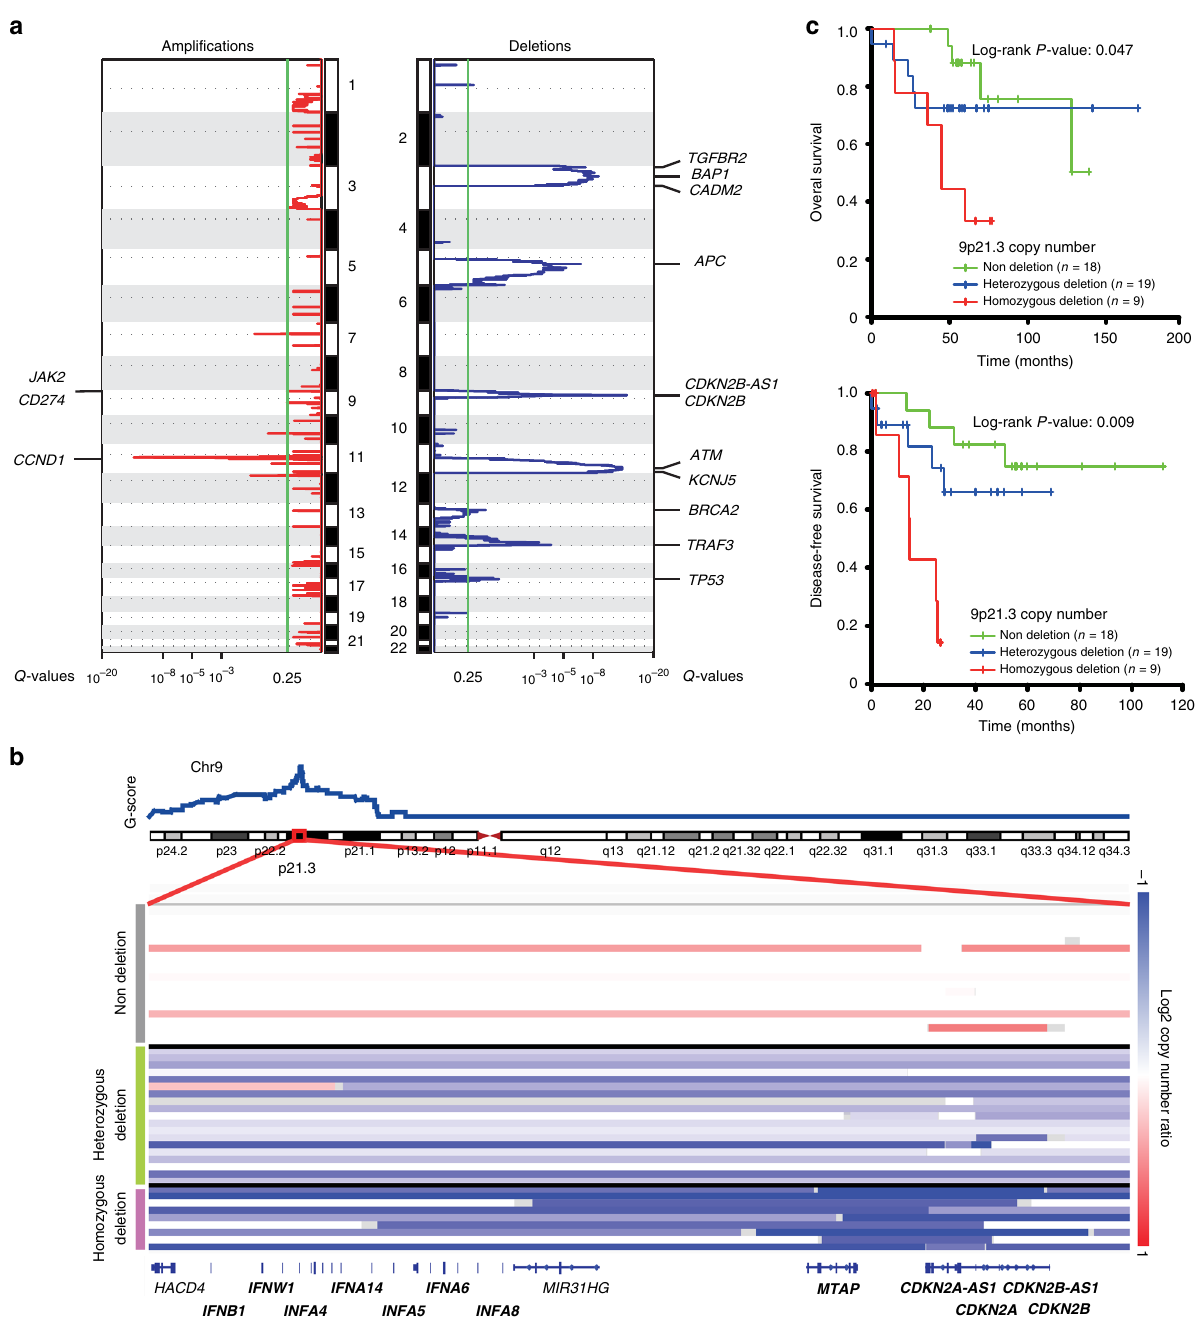
Fig. 2 Analysis of copy number alterations in pulmonary LELC. a Focal ampli fi cation and deletion determined from GISTIC 2.0 analysis. The plot shows signi fi cant ampli fi cation (red) or deletion (blue) for the chromosomes from 1 (top) to 22 (bottom). The green line indicates the cut-off for signi fi cance ( q = 0.25). Genes listed on left (for ampli fi cations) and right (for deletions) are likely drivers located in the peak areas de fi ned by GISTIC 2.0. b Zoom in the signi fi cant deletion region in p21.3 of chromosome 9. Samples are classi fi ed into three groups: samples without deletions; samples with heterozygous deletions; and samples with homozygous deletions. c Kaplan – Meier survival analysis for three groups with different copy number status of 9p21.3. Statistical signi fi cance was estimated by two-sided log-rank test. LELC, lymphoepithelioma-like